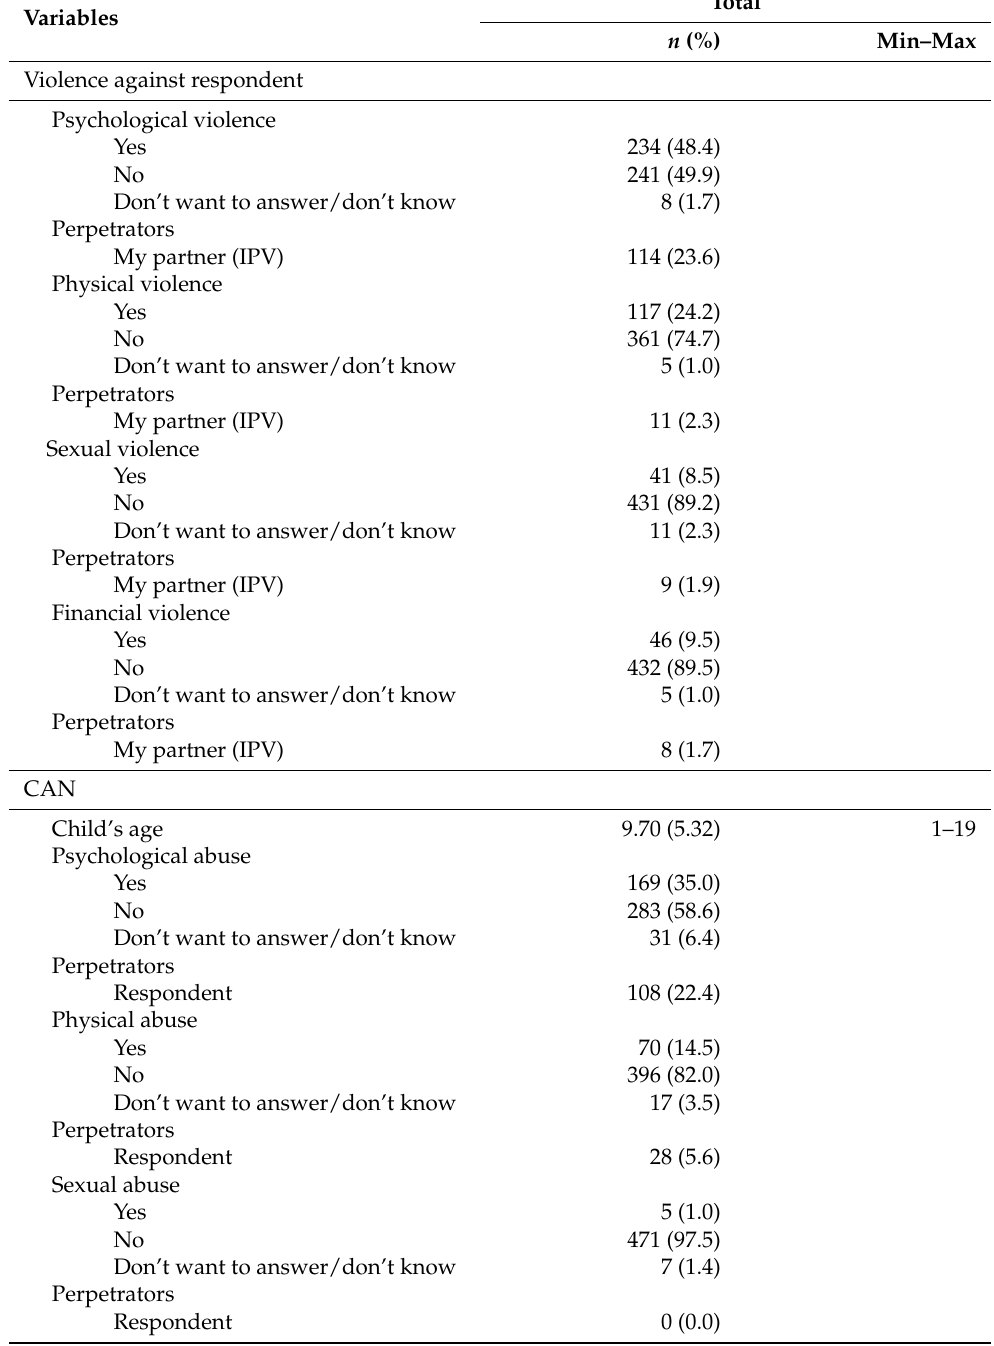
Table 2. Descriptions of the Japanese version of the Family Poly-victimization screen (FPS-J) ( n =